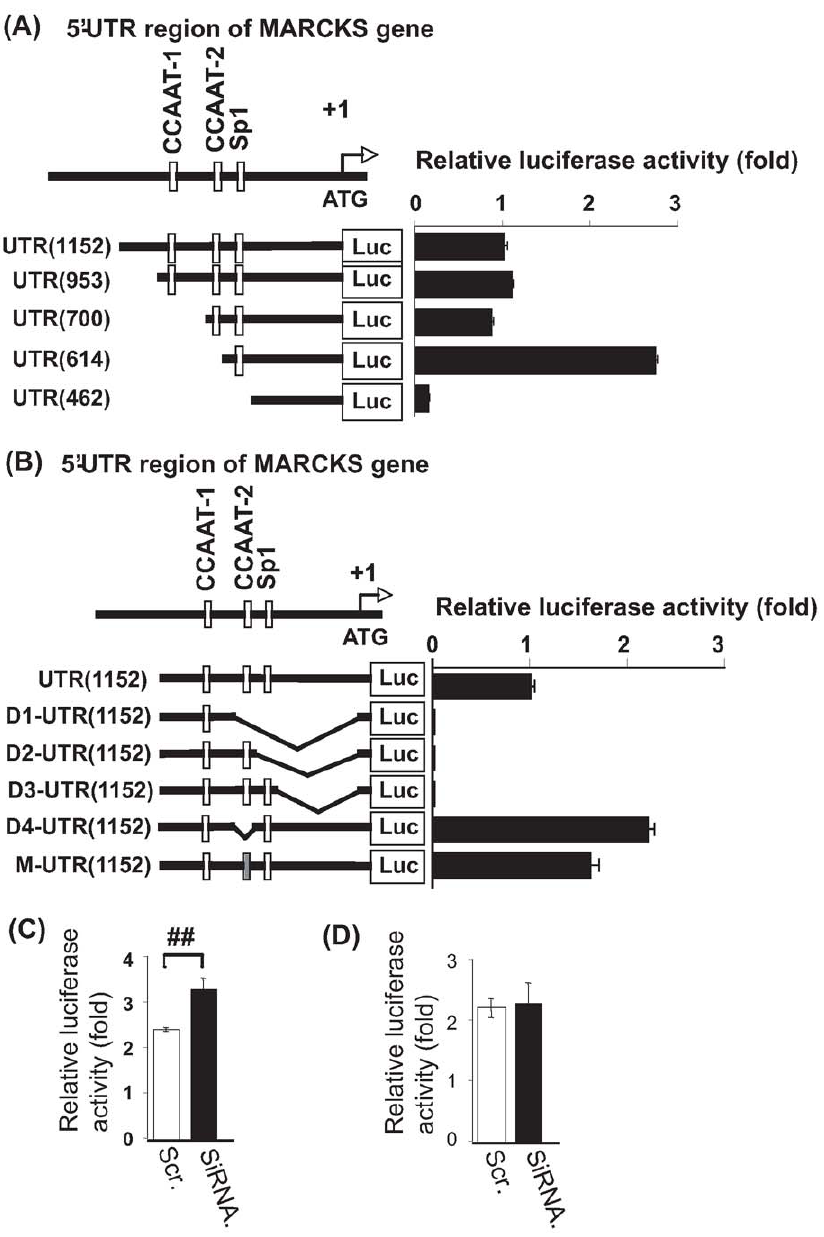
Figure 4. Dysbindin regulates the transcription of MARCKS via the CCAAT2 sequence. (A) The following five vectors were used for luciferase assay, containing shorter DNA probes; UTR(1152)-Luc, UTR (953)-Luc, UTR(700)-Luc, UTR(614)-Luc, and UTR(462)-Luc, were transfected into SH-SY5Y cells and Luciferase activity was measured. UTR(614), which lacks CCAAT1, showed increased luciferase activity. The luciferase activity of UTR(1152) was used as control. Columns and vertical bars denote the means 6 SEM (triplicate independent experiments). (B) UTR(1152)-Luc vector and deleted or point mutation of UTR(1152)-Luc vectors, [D1-UTR(1152)-Luc], [D2-UTR(1152)-Luc], [D3-UTR(1152)-Luc] [D4-UTR(1152)-Luc] and [M- UTR(1152)-Luc], were transfected into SH-SY5Y cells and Luciferase activity was measured. [D4-UTR(1152)-Luc], which lacks CCAAT2, and [M- UTR(1152)-Luc], which has a point mutation in the CCAAT2 sequence, showed increased luciferase activity. The luciferase activity of UTR(1152) was used as the control. Columns and vertical bars denote the means 6 SEM (triplicate independent experiments). (C and D) Scrambled RNAi-transfected SH-SY5Y cells and Dysbindin RNAi-transfected SH-SY5Y cells were transfected with the UTR(1152)-Luc vector (C) or D4-UTR(1152)-Luc (D) and Luciferase activity was measured. UTR(1152)-Luc vector-expressing cells showed the effect of Dysbindin expression levels on luciferase activity, but D4-UTR(1152)-Luc expressing cells did not. Columns and vertical bars denote the means 6 SEM (triplicate independent experiments; P , 0.001, Student’s